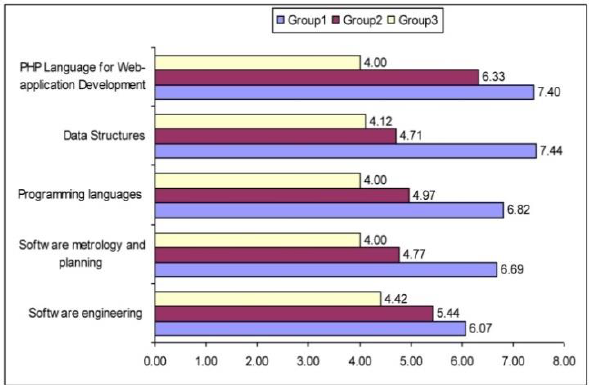
Fig. 2. The results of research.